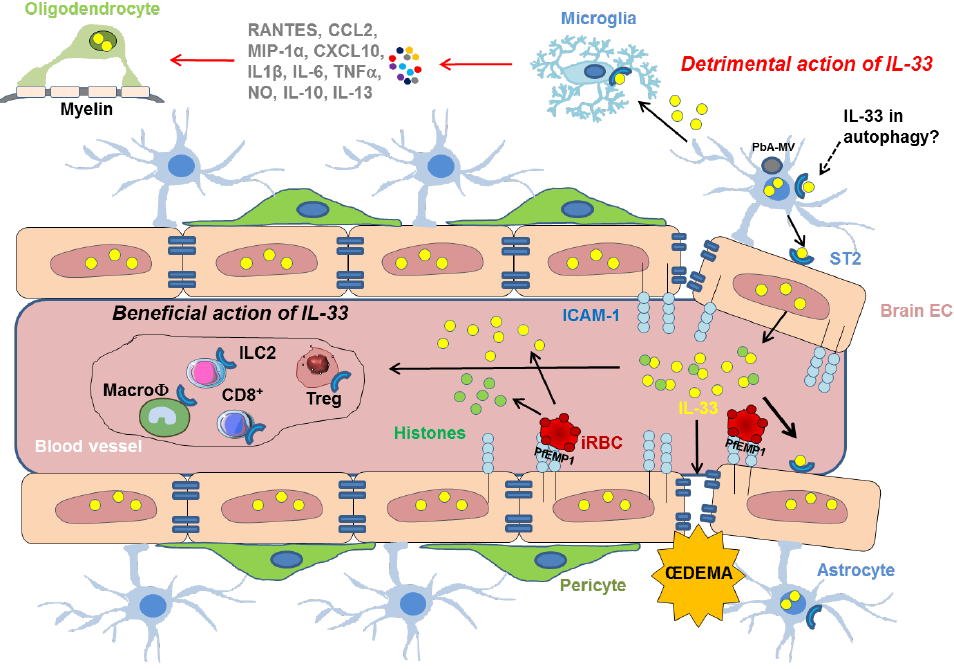
Figure 3. Mechanistic insights on the cellular and molecular players involved in the effect of IL-33/ST2 pathway, following the sequestration of iRBC in the vasculature of the BBB. IRBCs bind to ICAM-1 at the surface of endothelial cells via the Plasmodium erythrocyte membrane protein 1 ( Pf EMP1). IRBCs may also release IL-33 (yellow circles) that can activate ICAM-1 expression on EC promoting the binding of iRBC. Histones (green circles) released by iRBC may synergize with IL-33. IL-33 drives the expansion of ILC2 cells, leading to the polarization of the anti-inflammatory M2 macrophages, which in turn expand Tregs giving a beneficial role of the IL-33/ST2 pathway in ECM. IL-33 may also have detrimental activities by inducing vascular permeablity responsible for œdema and targeting cells involved in the integrity of BBB, such as microglia which can then produce IL- 1β resulting in neuroinflammation and IL -33 overexpression in oligodendrocytes. Autophagy pathways participate in the neuropathophysiological mechanisms of CM in driving the transfer of Pb A-microvesicles ( Pb A-MVs-grey circle) and the induction the proinflammatory response in astrocytes. This pathway could also involve the IL-33/ST2 activity.